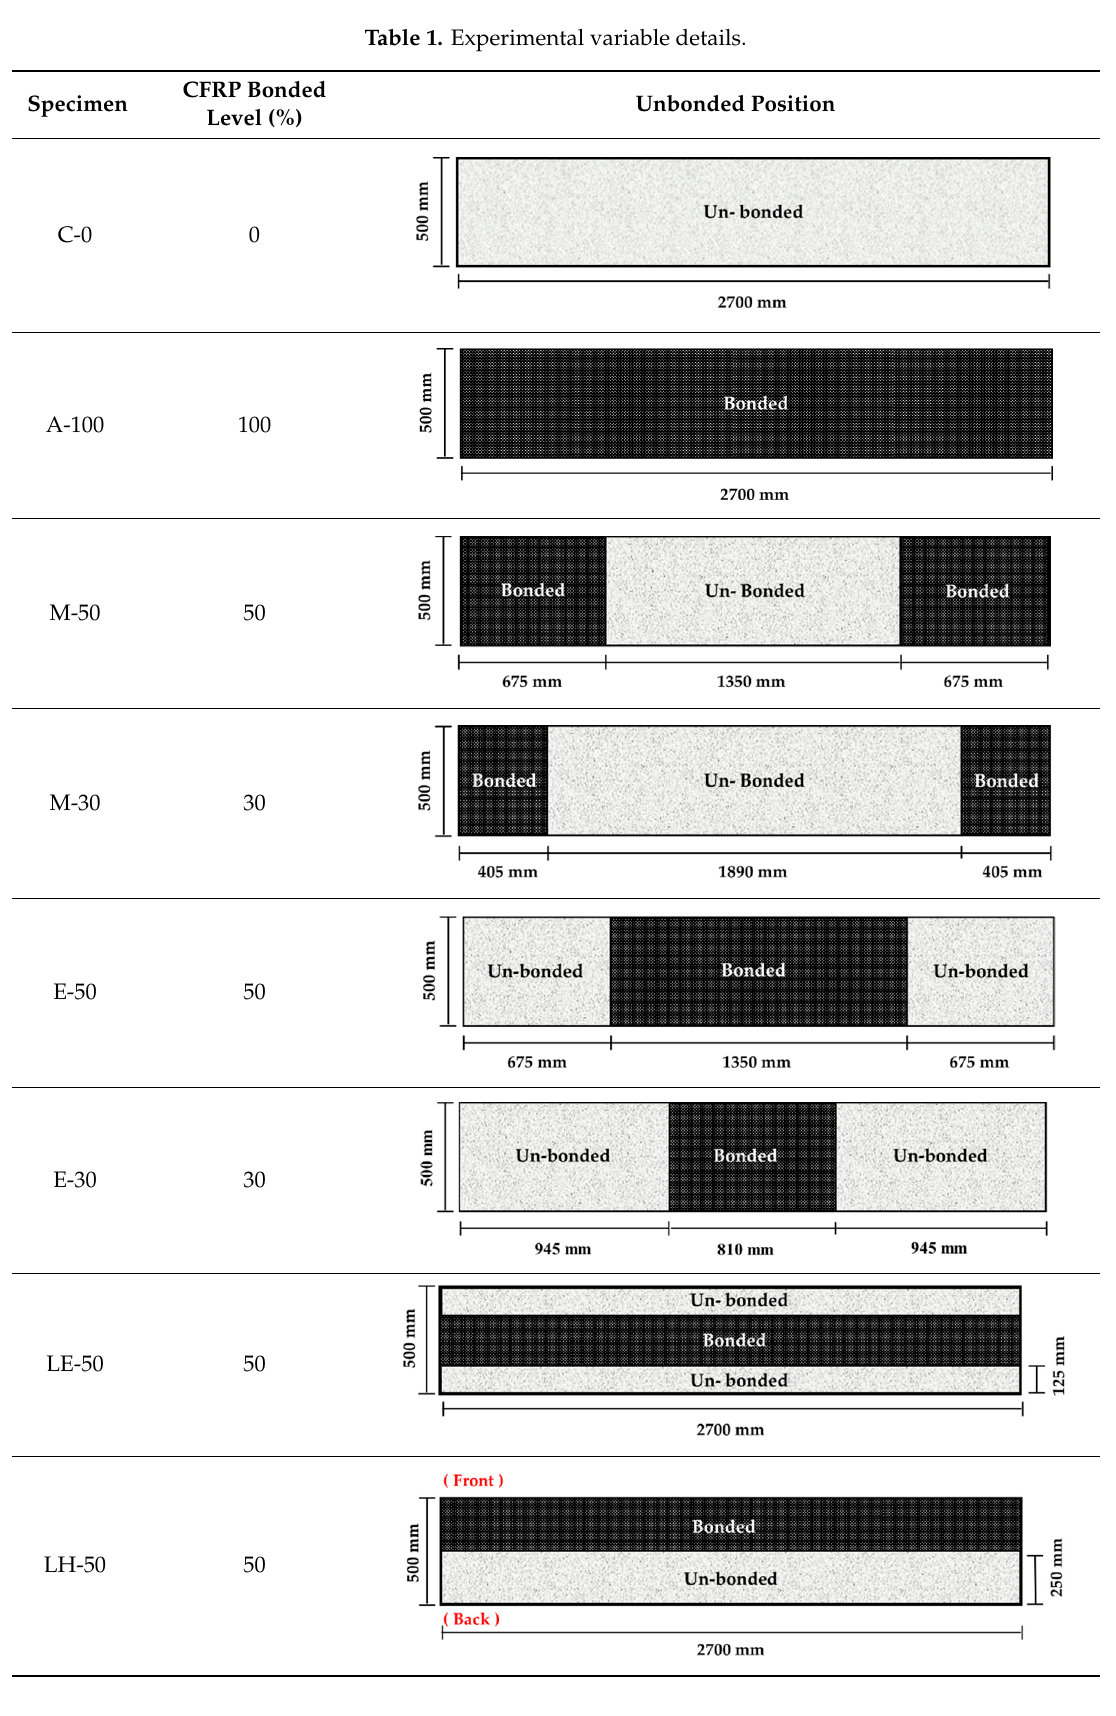
Figure 3. Test setup.